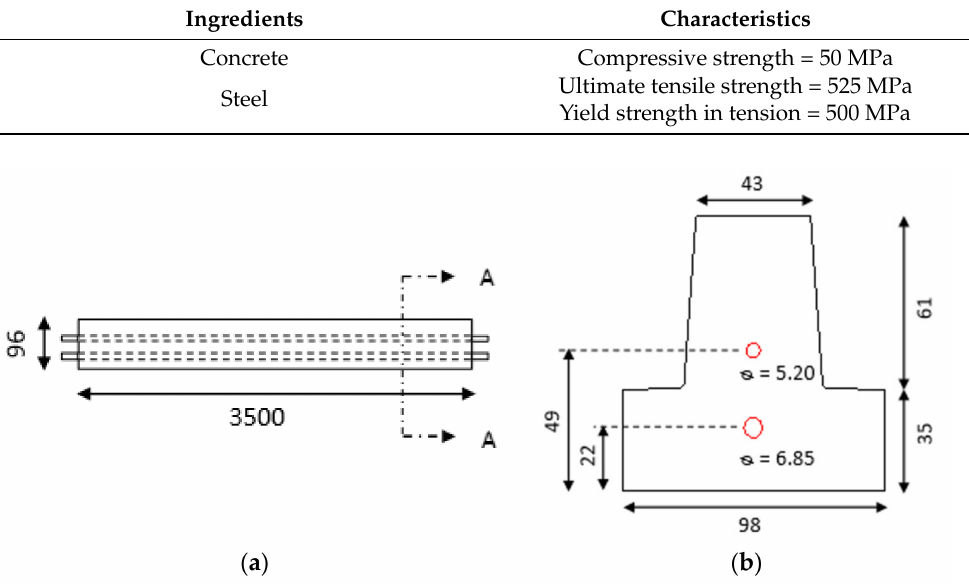
Table 1. Mechanical properties of the reinforced concrete T-beams as provided by the manufacturer (i.e., RECTOR ® ).